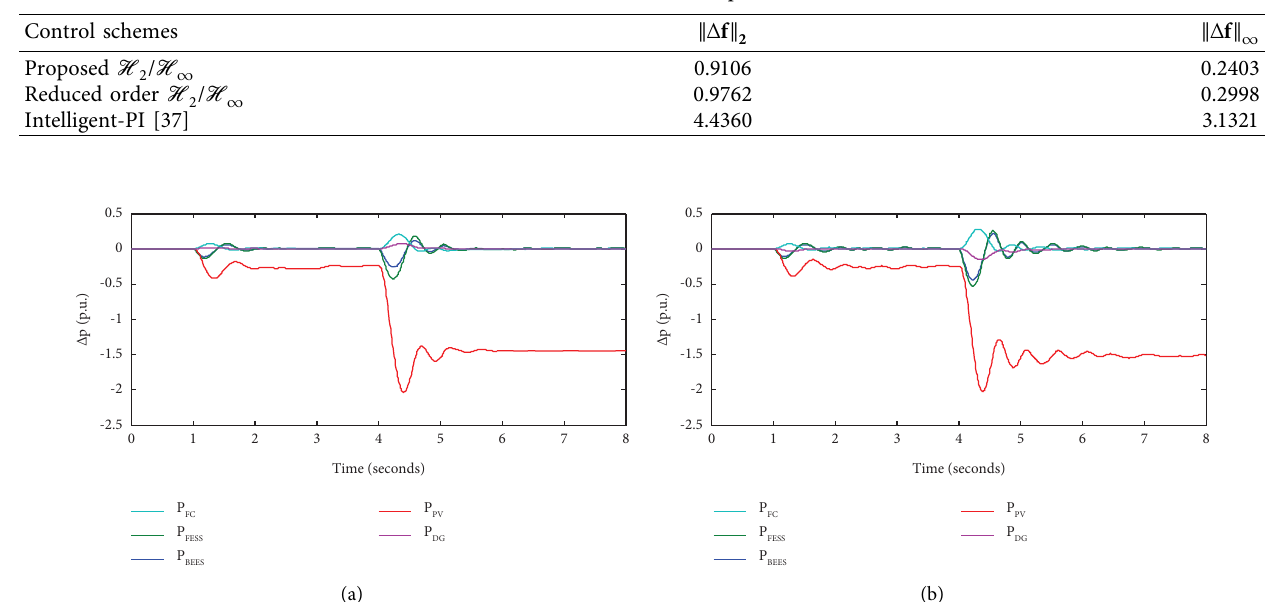
Table 4: Scenario III’s norm specifcation.